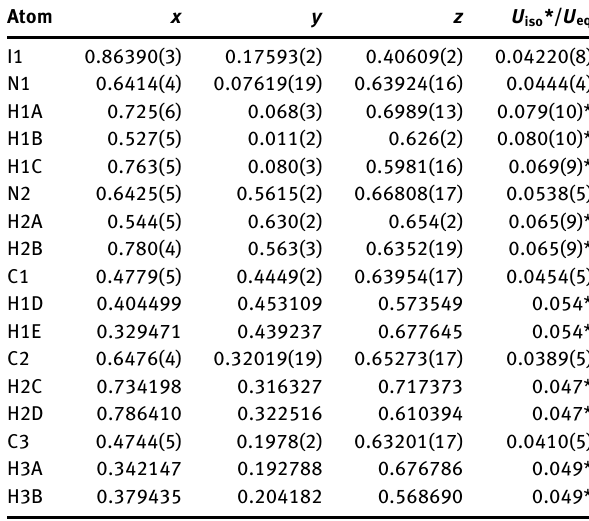
Table 2: Fractional atomic coordinates and isotropic or equivalent isotropic displacement parameters (Å 2